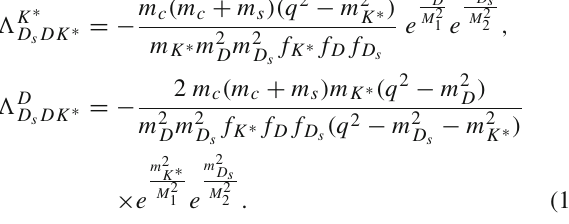
and quark–gluon condensates since the heavy quark c is a spectator.Figure4showsthesediagramsrelatedtothegluon– gluon